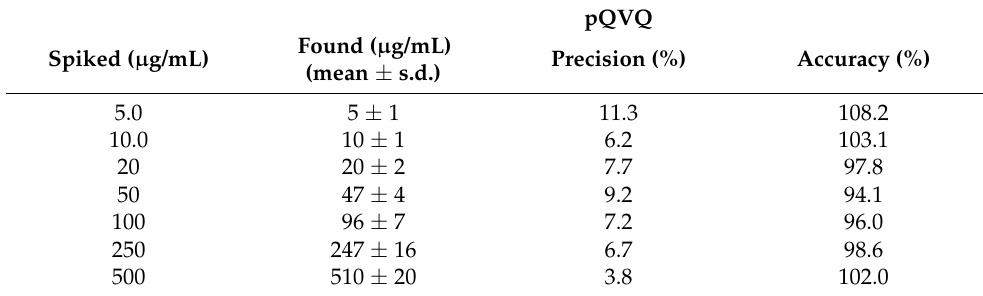
Table 4. Inter-day validation of the determination of rituximab in plasma by LC-MS-MS using pQVQ as a surrogate peptide. Data from twelve calibration curves were prepared as a single replicate and analyzed on twelve different